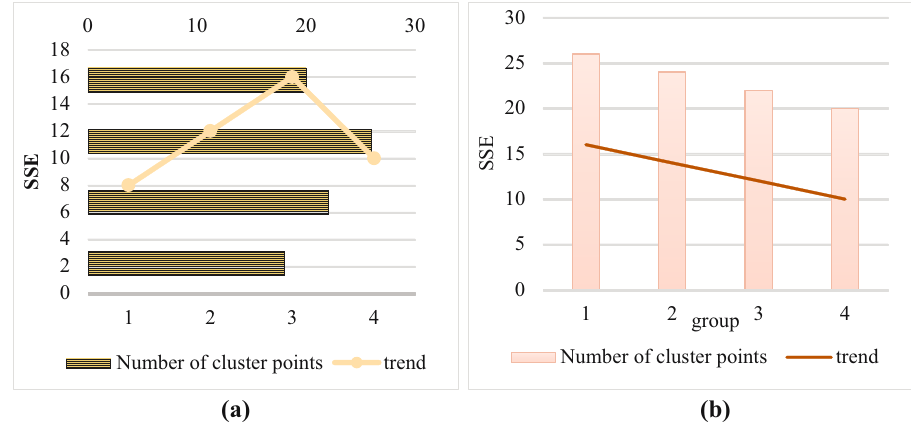
Figure 6: Results of the 3rd and 4th clustering experiments: ( a ) the 3rd clustering data and ( b ) the 4th clustering